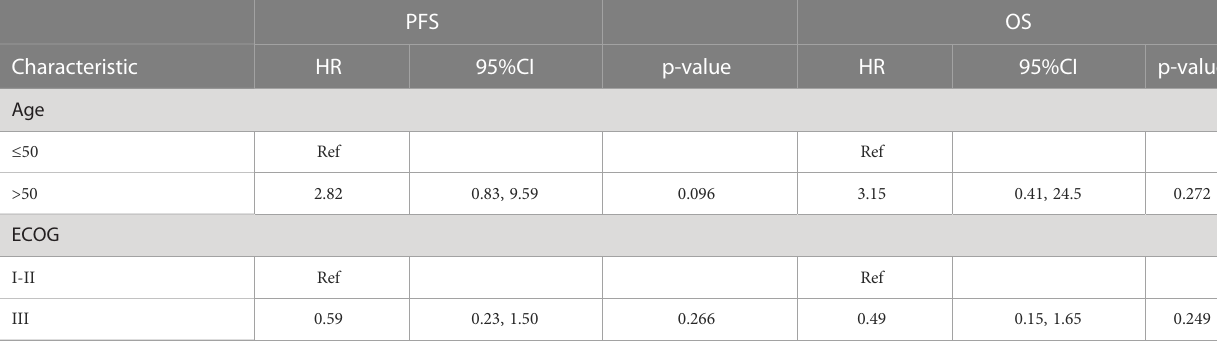
TABLE 2 Univariate cox regression analysis of clinical characteristics in all available samples.